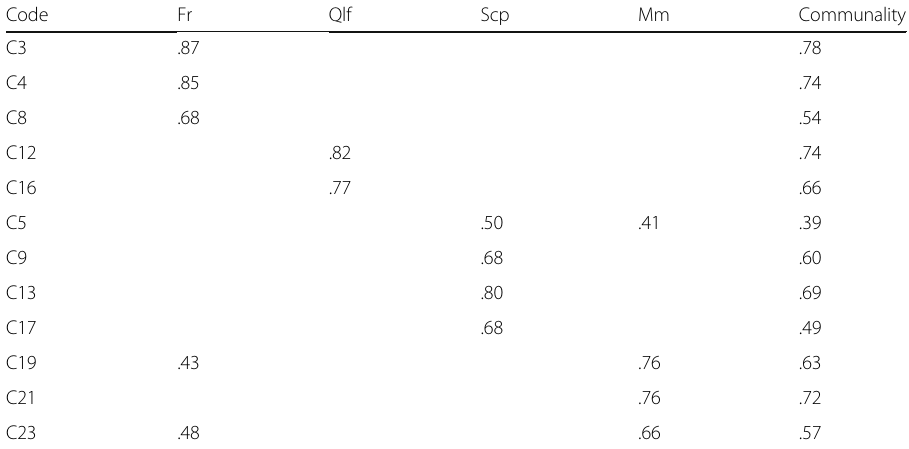
Table 5 Factor loadings and communalities for 12 items measuring surface approach ( N = 90)